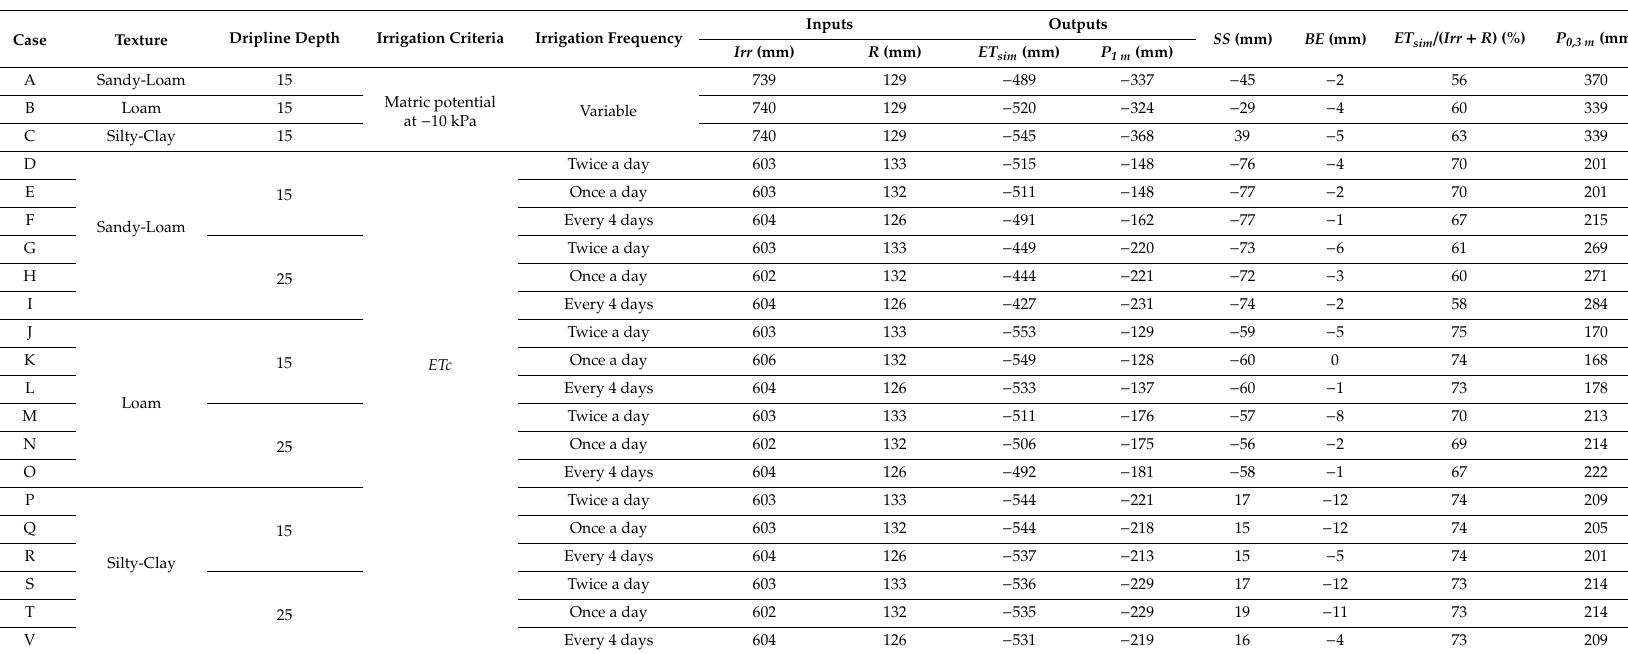
Table 4. Simulated water balance components (mm) considering 1 m depth of soil profile, water balance error (mm), relationship between simulated cumulative crop evapotranspiration ( ET sim ), and water inlets, and drainage below the maximum depth of roots (0.3